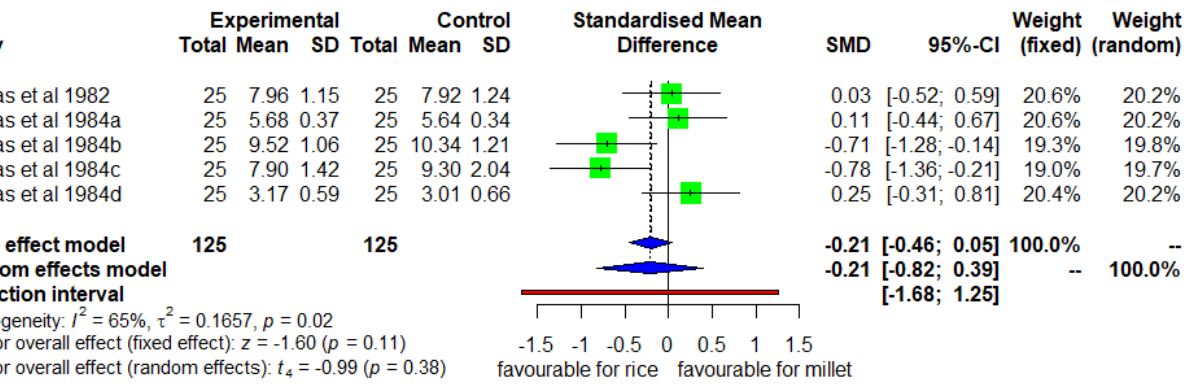
Figure 6. Effect of consuming an enhanced diverse millet-based diet on mean height change compared to an enhanced diverse rice-based diet.